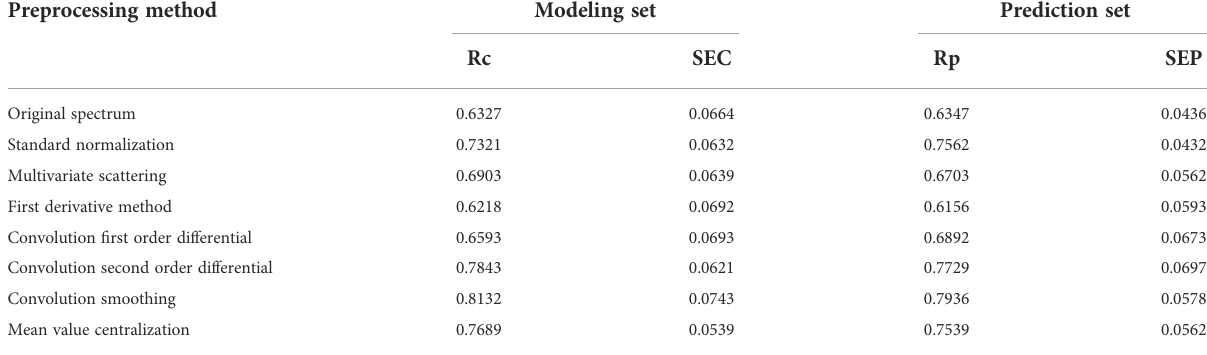
TABLE 2 Partial least squares modeling comparison of original spectral data and preprocessed data.